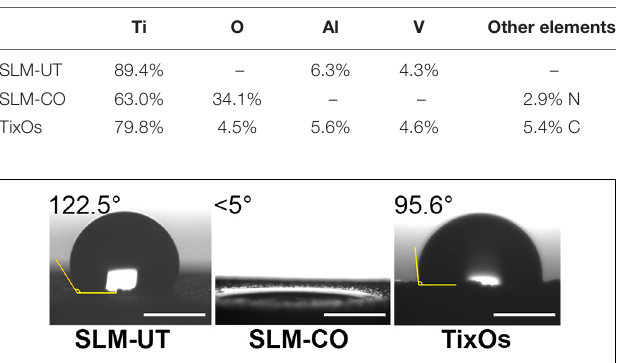
FIGURE 4 | The contact angle in the air with distilled water of three implants (bar = 0.5 mm).